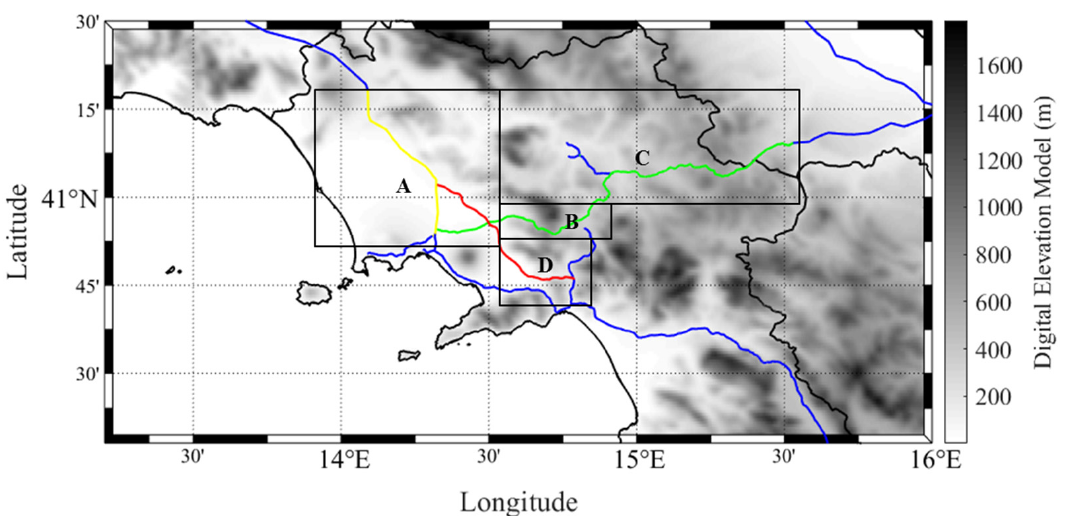
Figure 6. Map of the study area, including the four sub-regions (labeled as A, B, C and D) introduced in the design of the precipitation type algorithm. The limits of the sub-regions are bordered as a black line. The motorways of interest for the CARMEN project, i.e., A1, A16 and A30, are shown as yellow, green and red lines, respectively. The highways not involved in the CARMEN project are marked in blue, instead.